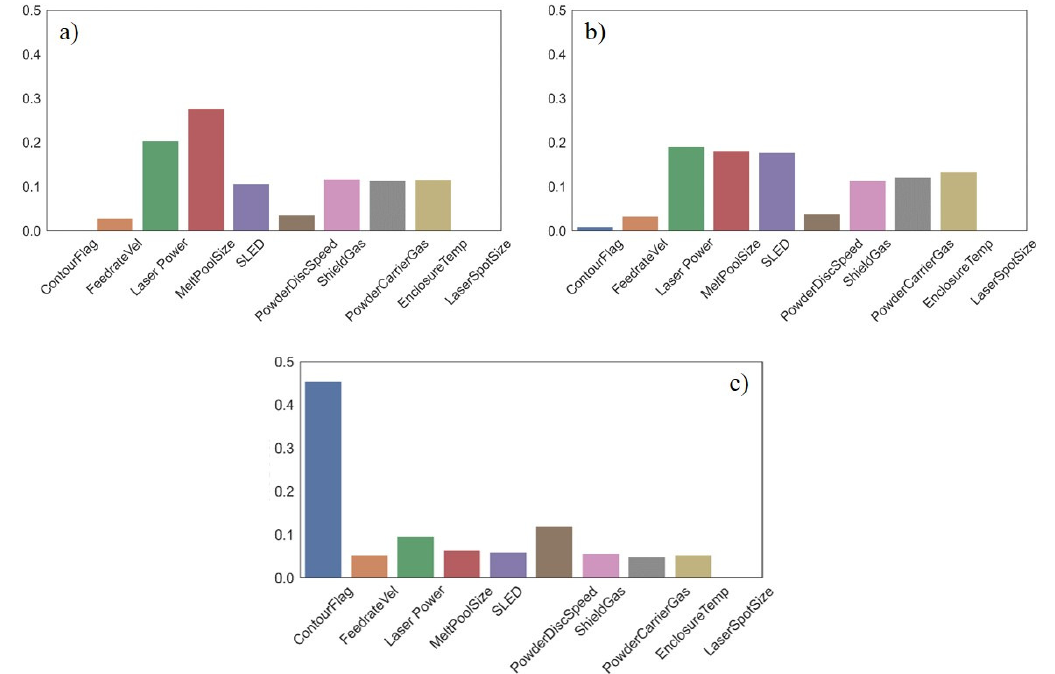
Figure 9. Feature importance bar plots: ( a ) Decision Tree, ( b ) Random Forest, ( c ) XGBoost.